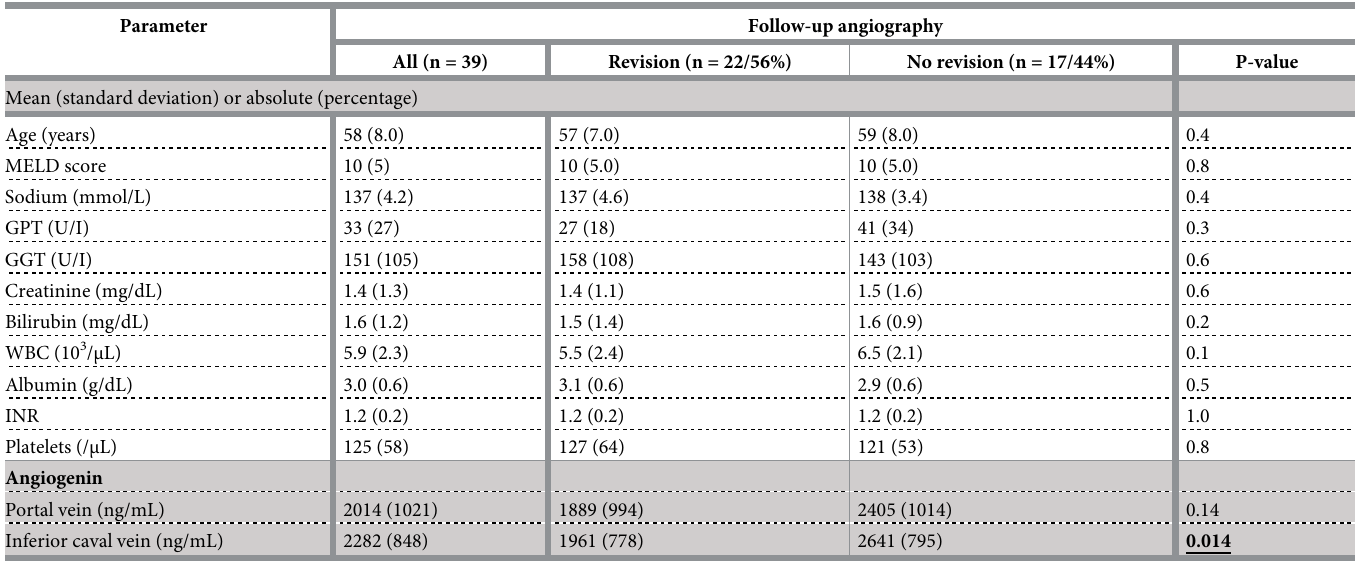
GGT: Gamma-glutamyltransferase; GPT: Glutamate pyruvate transaminase; INR: International normalized ratio; MELD: Model for end-stage liver disease; WBC: White blood cell